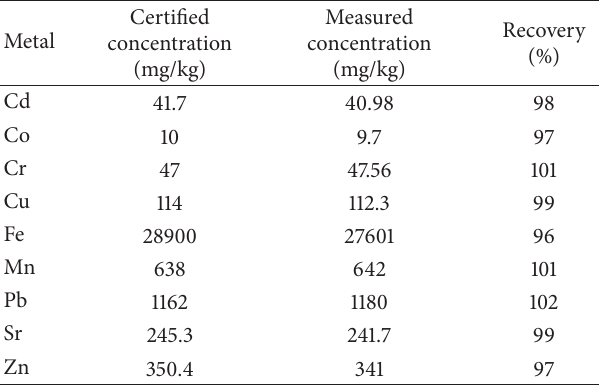
Table 1: Metal concentrations (mg/kg) and recoveries (%) in standard reference material